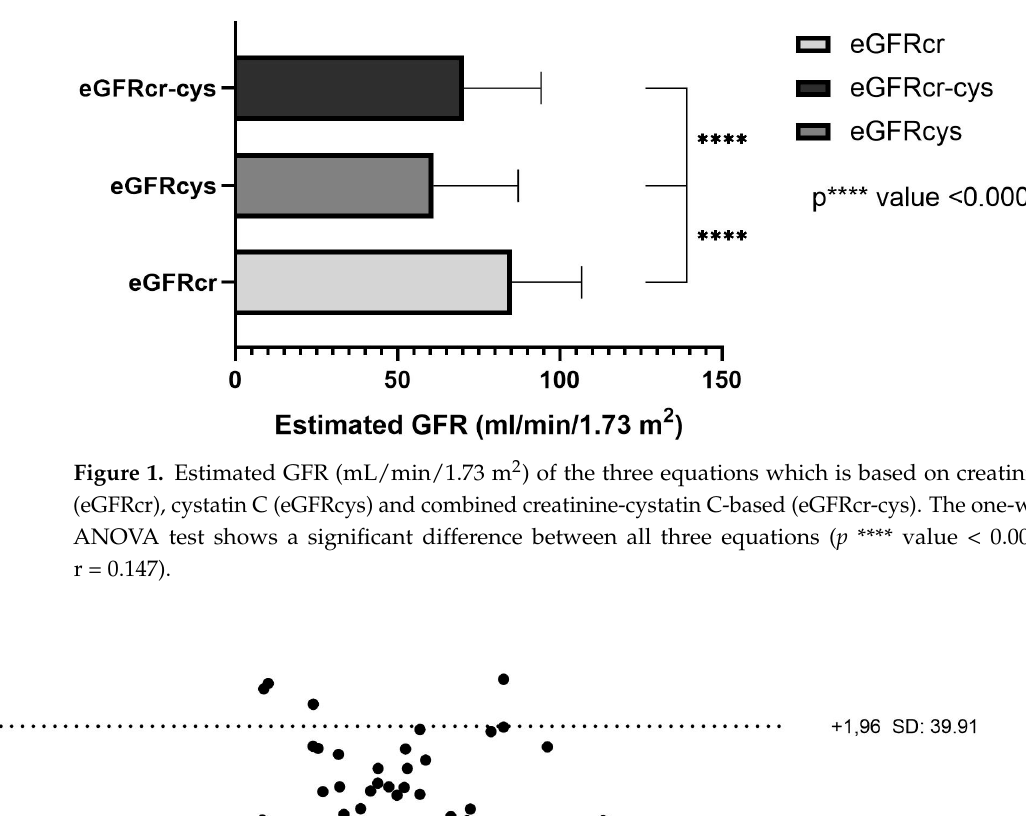
KDIGO. The difference is not significant in the one-way ANOVA test (Figure 3).